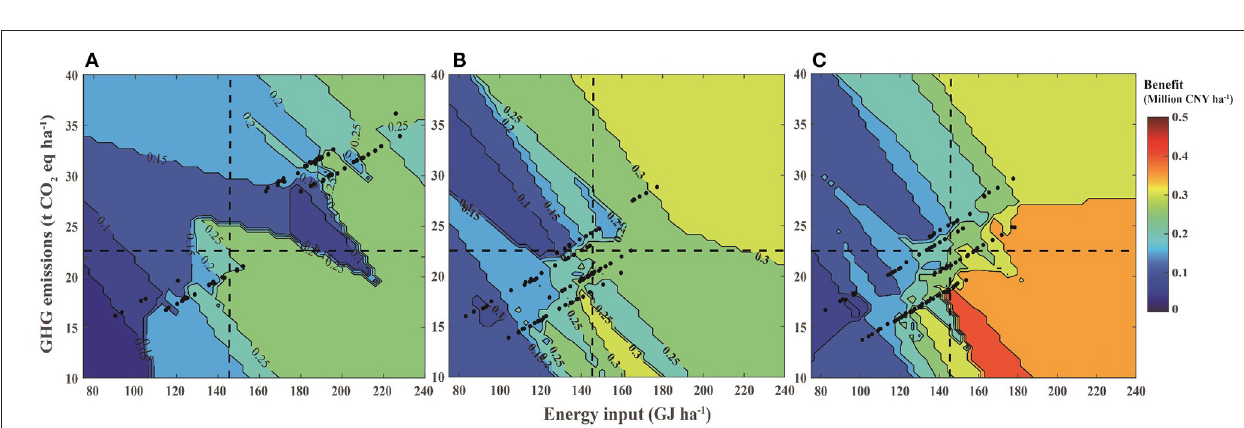
increased the energy inputs and GHG emissions in pomelo production by 4.20 and 6.21% ( Figures 4A , 5A ), respectively,